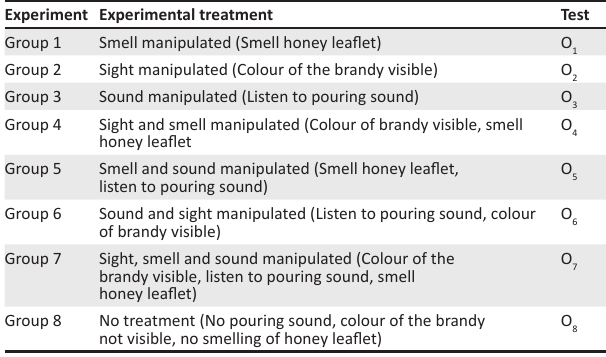
TABLE 1: Experimental